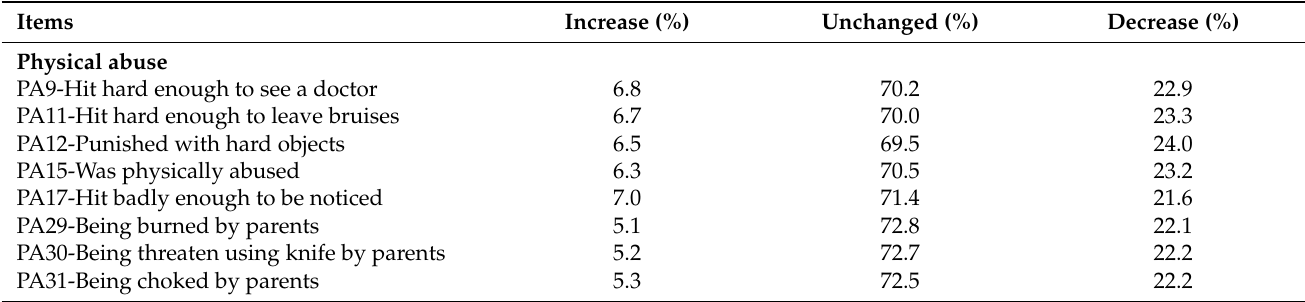
Table 1. Self-rated changes (%) for the child maltreatment measure during